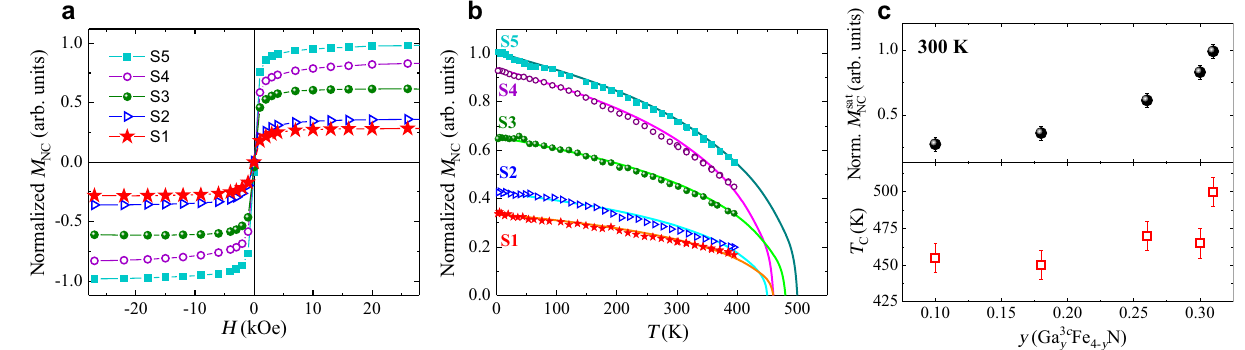
Figure 4. ( a ) Normalized M NC for all samples as a function of magnetic field H . ( b ) Temperature T dependence of the normalized M NC acquired up to 390 K (symbols). Lines: Langevin M ( T ) fits. ( c ) Normalized M as a function of the amount of Ga y in 3 c